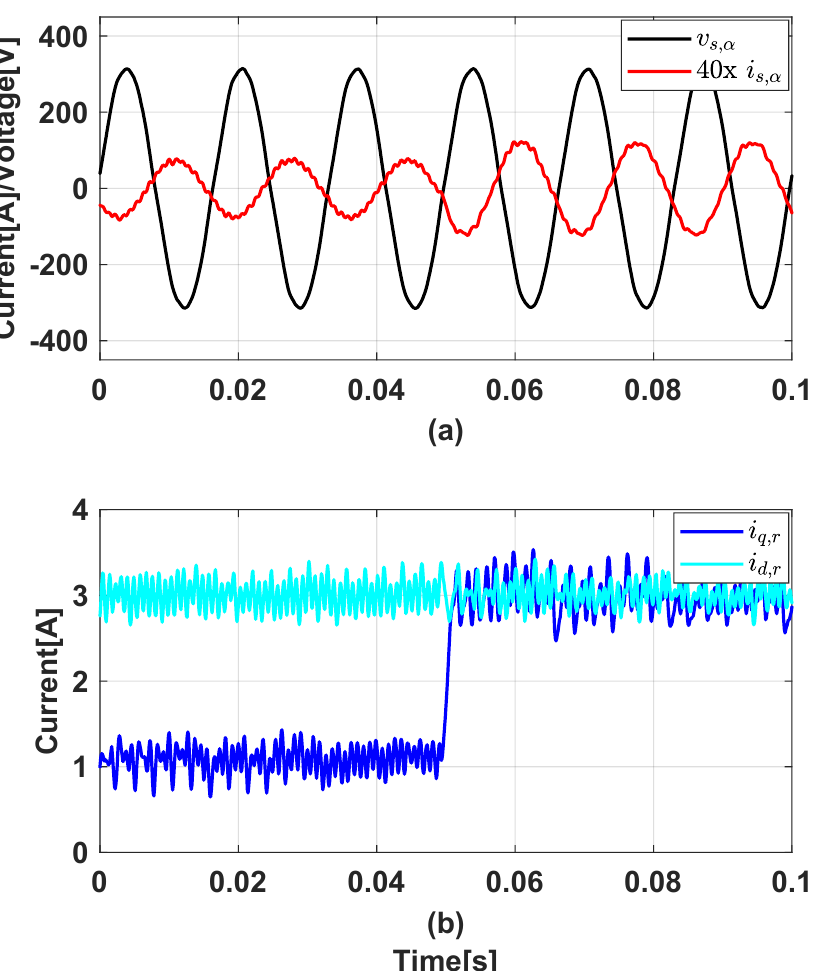
Figure 13. MPC dynamic response for DIFG: ( a ) current and voltage responses α components; ( b ) current response in the stationary frame dq .